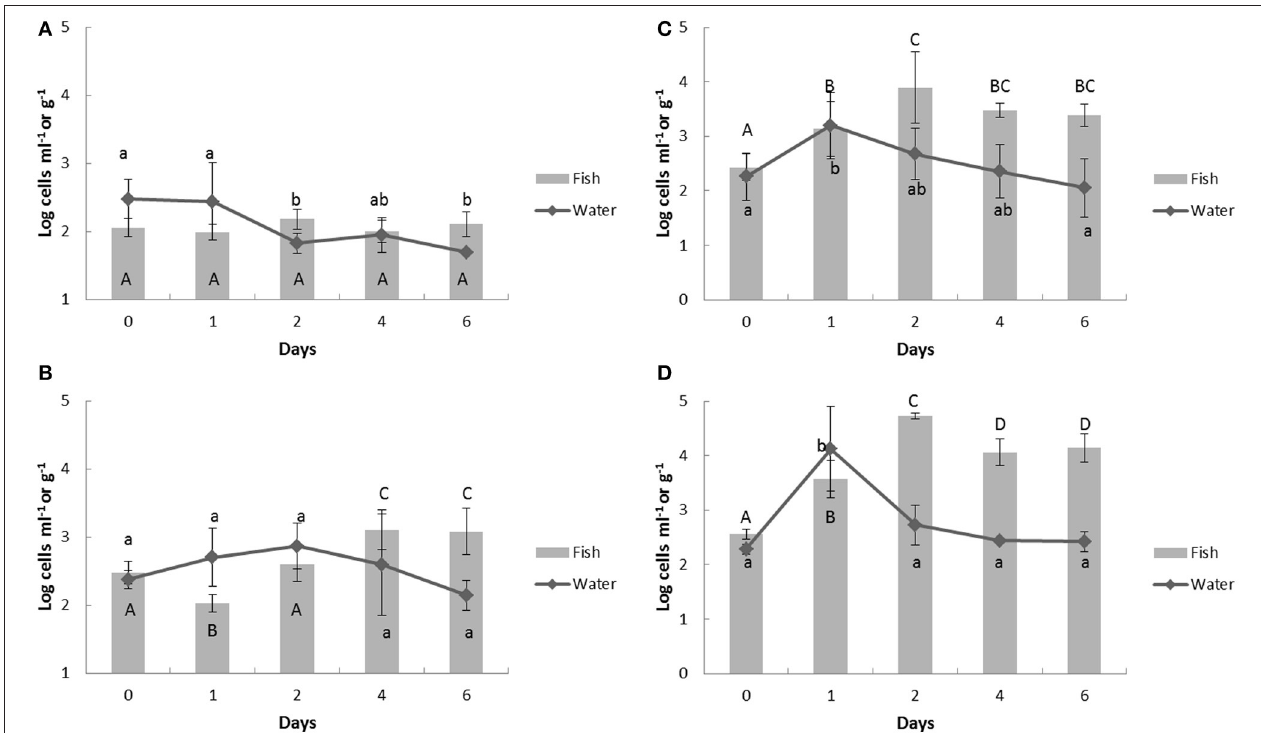
FIGURE 5 | Change of Vibrio vulnificus counts in aquaculture water and fish by multiplex real-time PCR assay in response to heat- inactivated Vibrio spp. challenge. Bold (A) control group; (B) group 2; (C) group 3; (D) group 4. The Vibrio spp. were challenged in the aquaculture water at day and the samples were collected at 24 h before the challenge (day 0), 1 h after challenge (day 1), and further 2, 4, 6 days. The upper case represents significantly different grouping among fish samples and lower case shows the significant grouping between water samples by Tukey